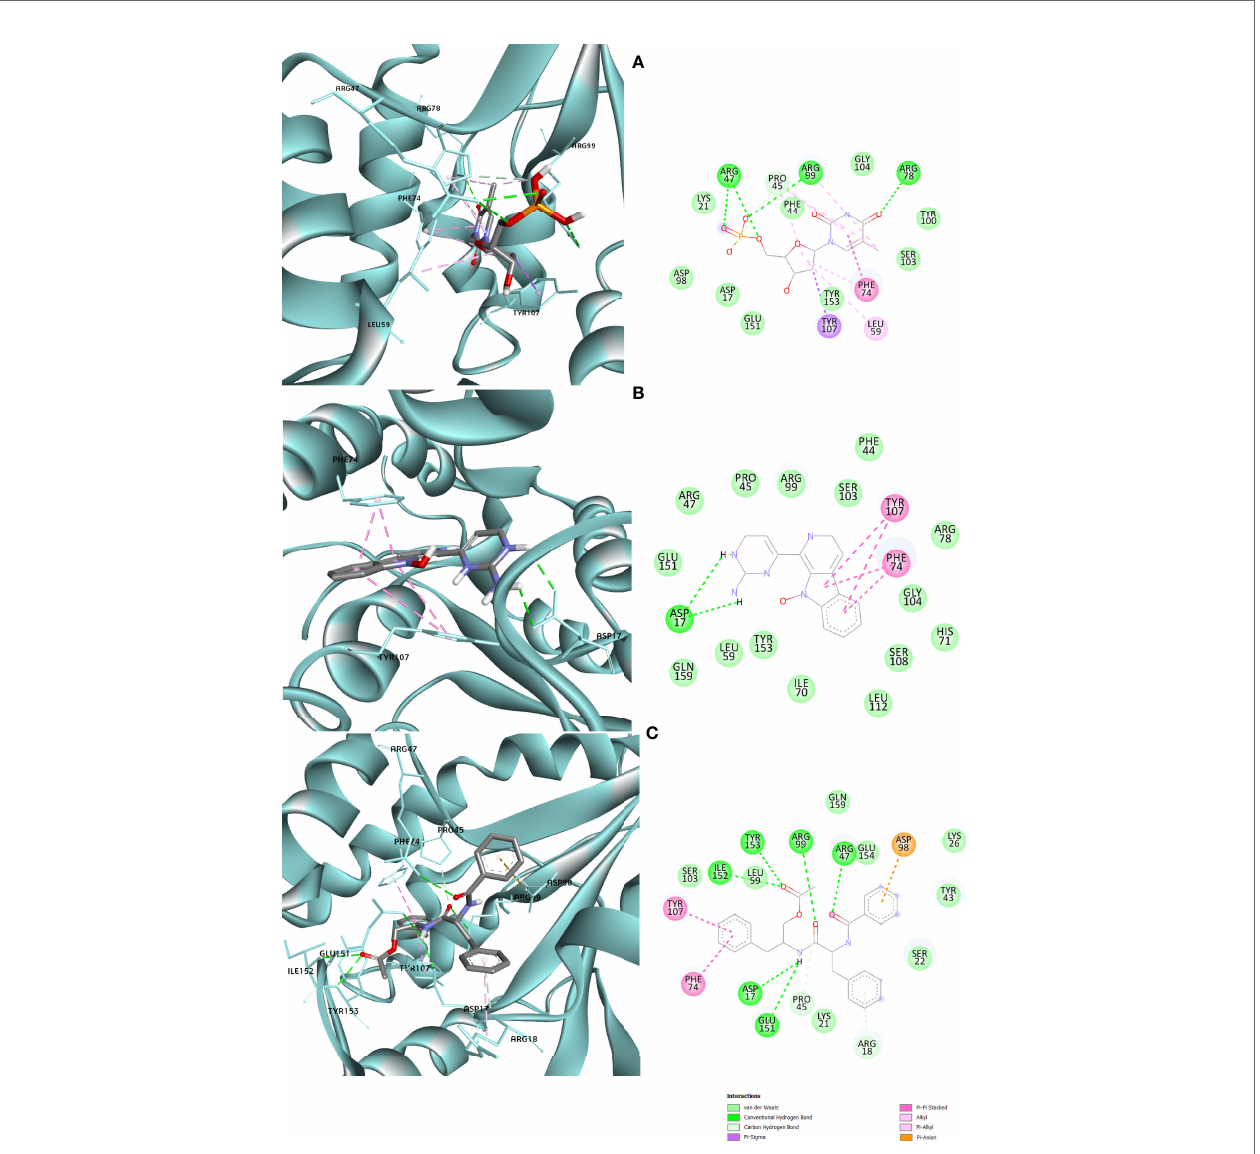
FIGURE 3 | 3D and 2D images of the protein – ligand interactions between Pf TMPK and (A) TMP, (B) ZINC13365918, and (C) ZINC13374323. TMP forms H-bonds with Arg47, Arg99, and Arg78; ZINC13374323 is shown to have H-bond interactions with Arg99, Arg47, Asp17, Glu151, Ile152, and Tyr153; ZINC13365918 forms H-bonds with only